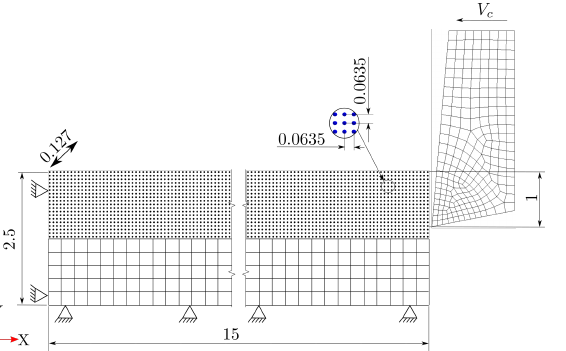
Figure 2. Two-dimensional machining model with geometry and boundary conditions.